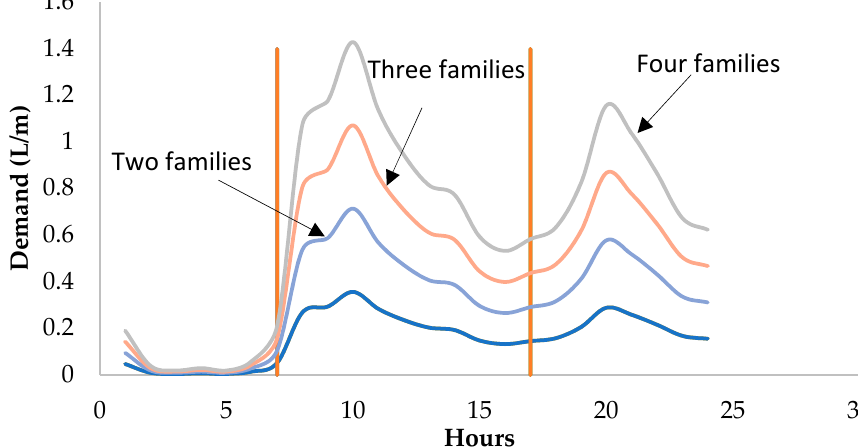
Figure 3. Typical domestic hot water demand for different numbers of families.